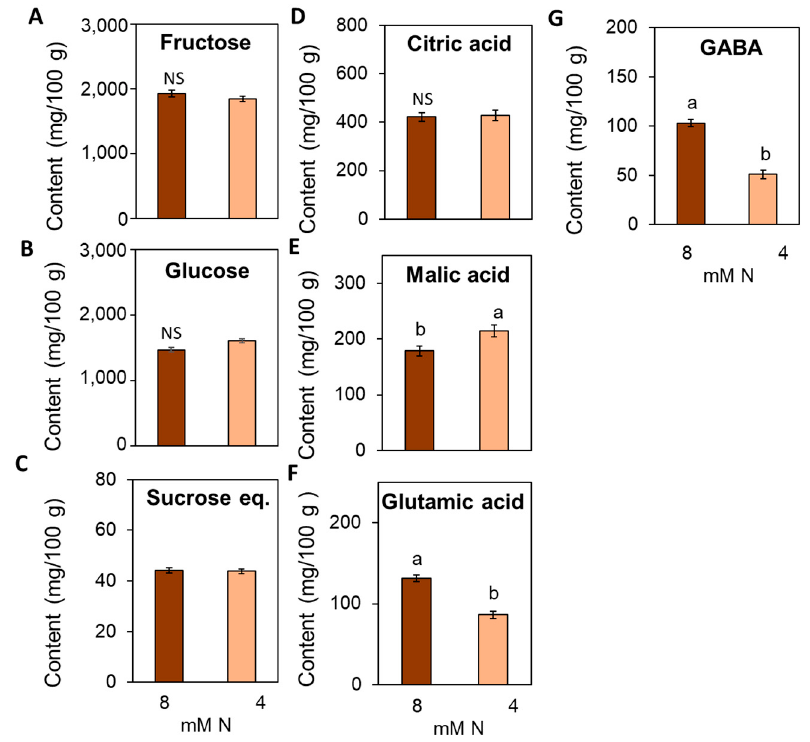
Figure 8. Changes in metabolite contents related to organoleptic quality in the fruits of plants grown using 8 and 4 mM N supply. Sugars ( A ) glucose and ( B ) fructose, sucrose equivalents ( C ), organic acids ( D ) citric and ( E ) malic acid, and amino acids ( F ) glutamic acid and ( G ) GABA contents (mg/100 g FW) were determined in mature red fruits. Each value is the mean of three determinations in different fruits. Different letters indicate significant differences ( p < 0.05).